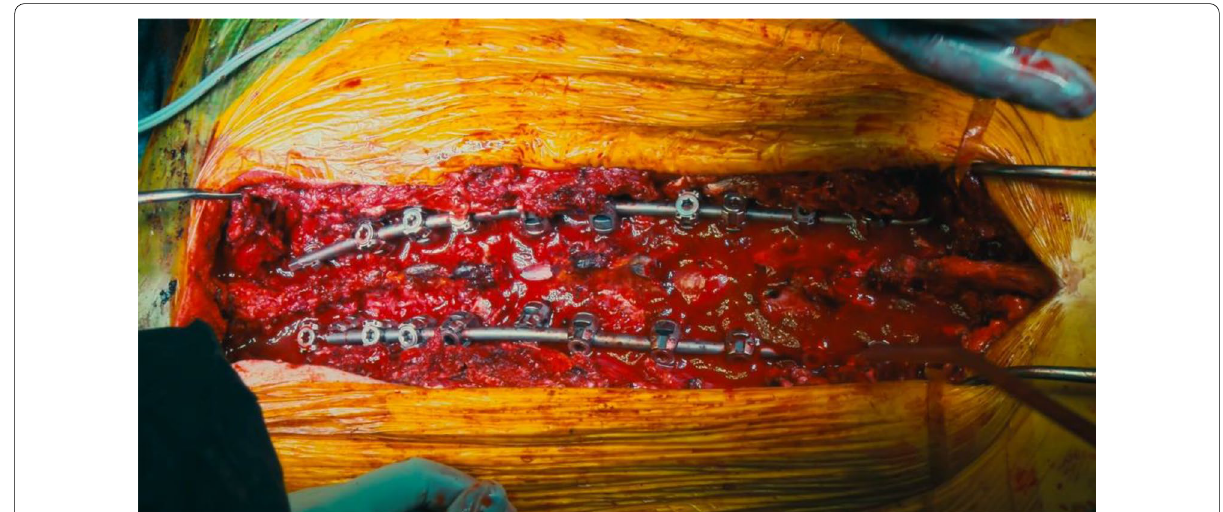
Fig. 8 Definitive rods are placed after both osteotomies are